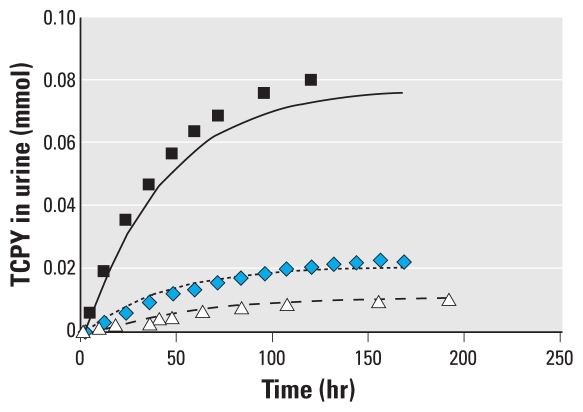
Pharmacokinetic curves for TCPY (mmol) in urine following an oral dose of 0.5 mg/kg and dermal application of 5 mg/kg in humans. The lines are the PBPK model simulations compared with the oral data from Nolan et al. 1984 (square) and Timchalk et al. 2002a (diamond) and to the dermal data from Nolan et al. 1984 (triangle).